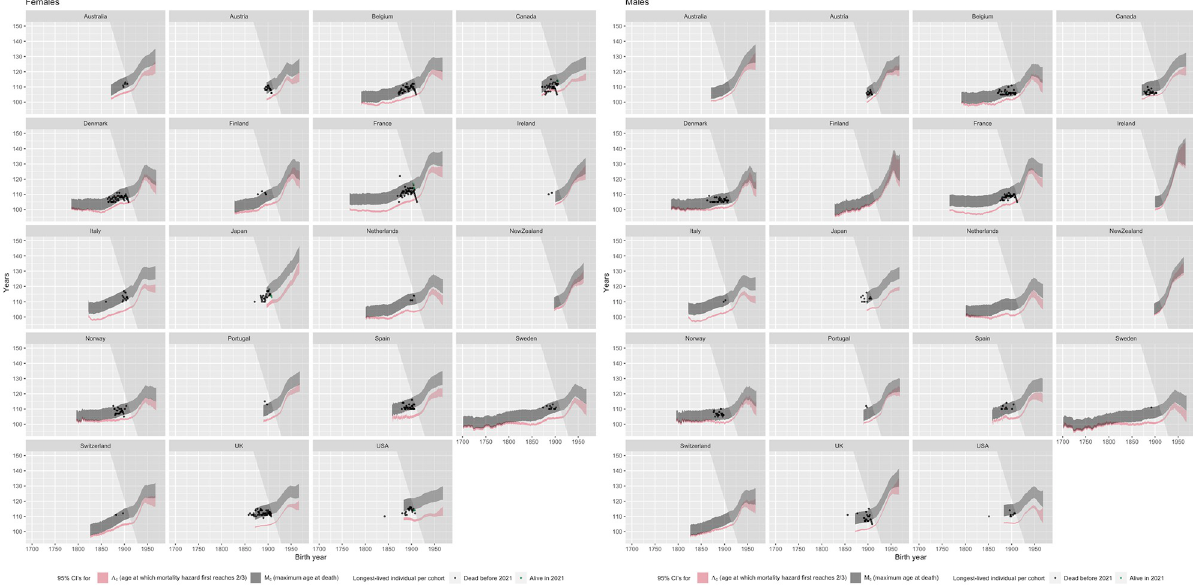
Fig 8. 95% confidence intervals for the length of maximum life ( M , grey) and the Gompertzian maximum age ( Λ , red). N OTE : Dots in the figures c c show the age at death (black dots) and current age (green triangles) of the longest-lived person in each birth cohort, from the IDL [22] and the GRG [23]. IDL data contains people over the age of 105 or 110 (depending on country); GRG data only show people over the age of 110. The mean length of maximum life increases due to compression and population increase (because more people are expected to reach age Λ c ) as well as postponement. Confidence intervals for M c are conditional on at least one person reaching age Λ c . Unconditional upper confidence intervals for M c are always the same as the conditional ones, but the unconditional lower confidence interval may be smaller than shown in countries with small populations, especially for males. See methods section M3 for details.